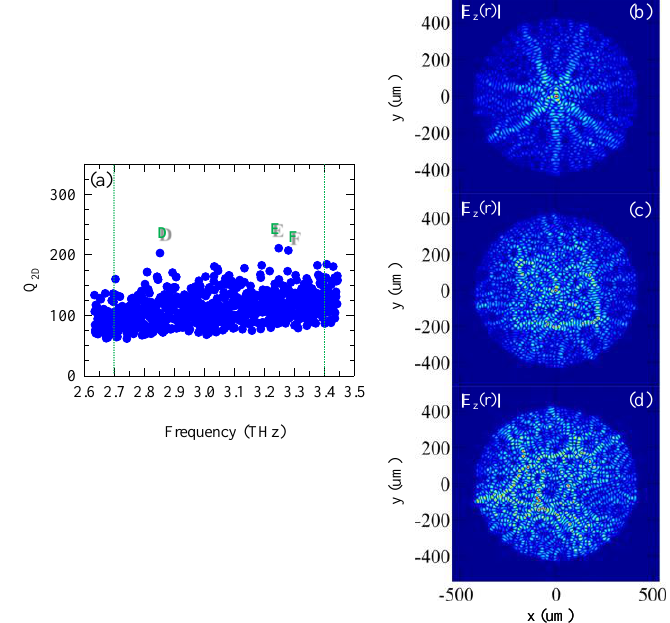
Figure 4. ( a ) Quality factor Q of the computed optical modes as a function of the radiation frequency